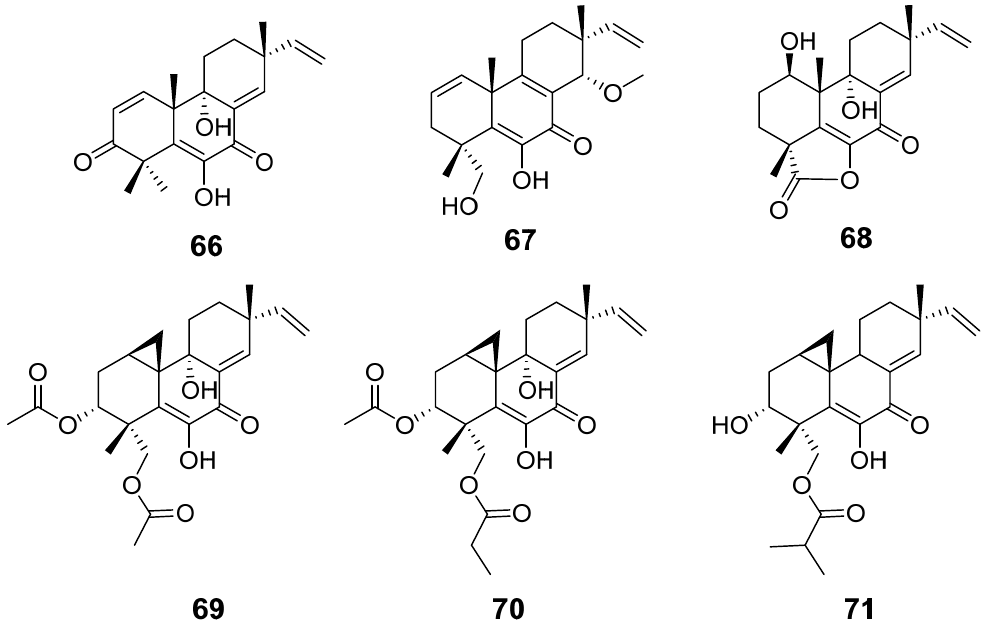
Figure 6. Structures of compounds 66 – 71 .